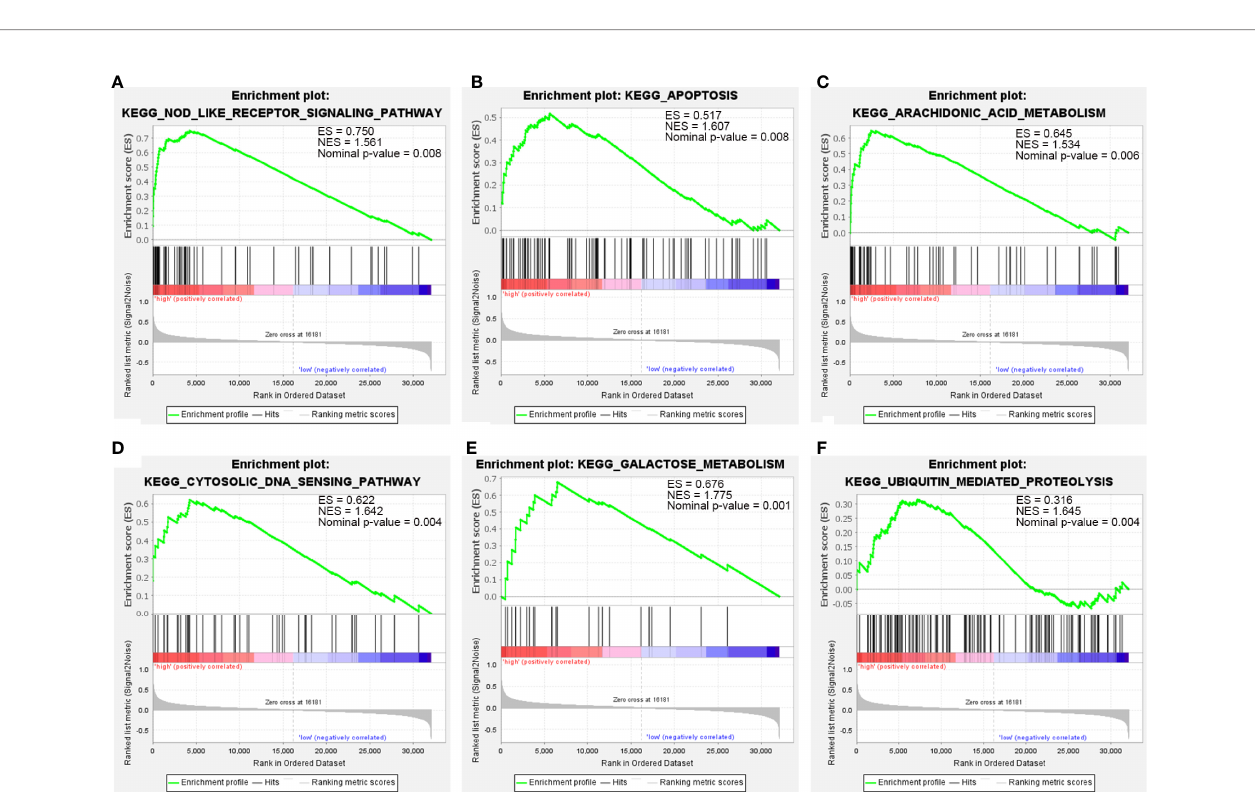
FIGURE 9 | The GSEA of IL1B. (A) NOD-like receptor signaling pathway. (B) Apoptosis. (C) Arachidonic acid metabolism. (D) Cytosolic DNA sensing pathway. (E) Galactose metabolism. (F) Ubiquitin-mediated